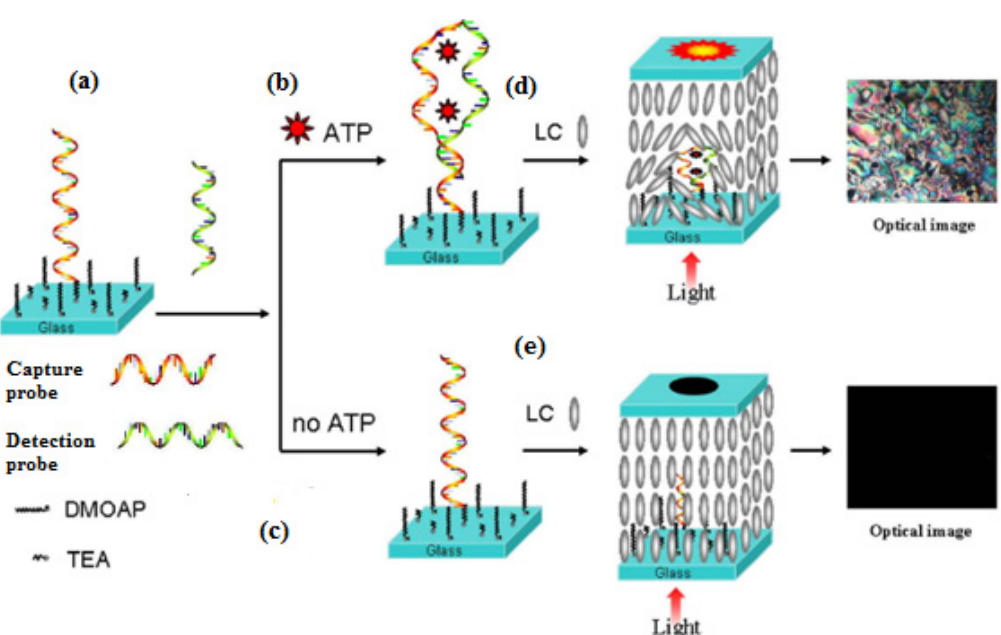
Figure 10. Stepwise assembly of the LC biosensing substrate based on ATP aptamer. (1) immobilization of capture DNA probe on the TEA / DMOAP mixed SAM modified glass slide ( a ); (2) hybridization with detection DNA in the presence of ATP ( b ) or in the absence of ATP ( c ); (3) The corresponding 5CB LC cells ( d , e ) fabricated with the DMOAP-coated glass slides (upper) and the modified slides ( b , c ; lower) [31].